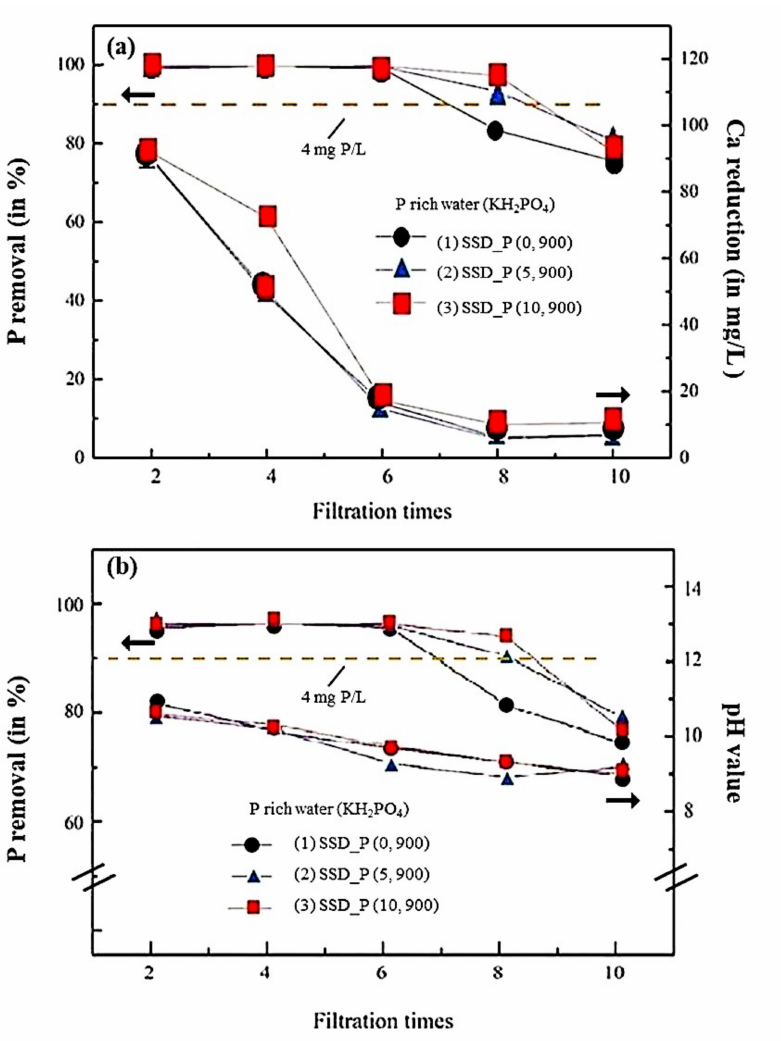
Figure 4. ( a ) The relations between filtering performances (P removal rates) and the released concen- trations of Ca 2+ as a function of filtering times are demonstrated for SSD_P (x, y) (x = 0, 5, 10 wt%, y = 900 ◦ C ). ( b ) The relations between filtering performances (P removal rate) and pH values in the filtrated water as a function of filtering times are demonstrated for SSD_P (x, y) (x = 0, 5, 10 wt%, y = 900 ◦ C). The effluent standard limit of P ion under 4 mg/L is marked as an orange dash